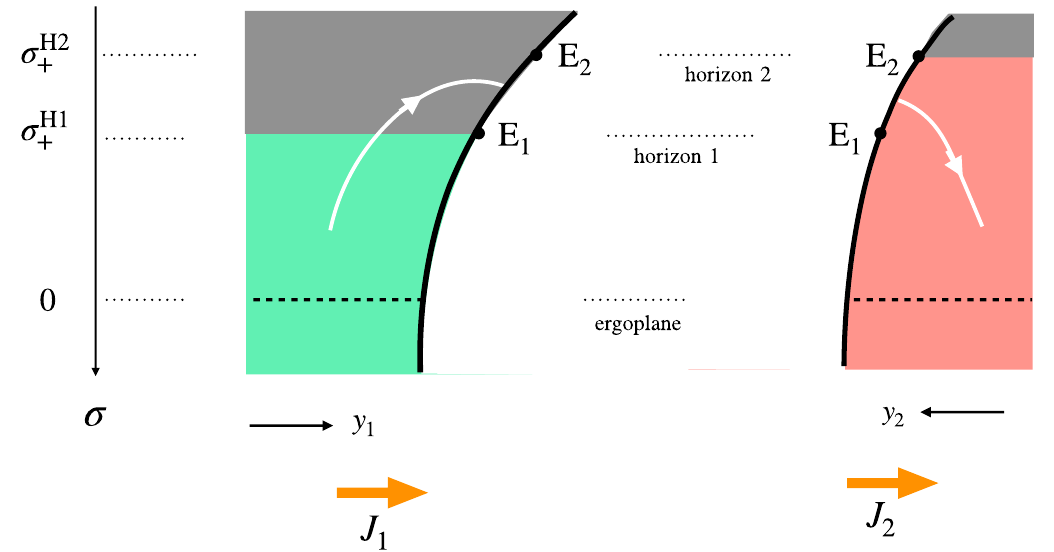
Figure 5 . A brane (thick black curve) entering the local outer horizons H 1 and H 2 (the boundaries of the grey regions in the figure) at two different points E1 and E2. The piece [E1,E2] of the wall is behind the horizon of slice 1 but outside the horizon of slice 2. The thick orange arrows show the direction of heat flow. The white curve is the worldline of an observer entering H 1 , crossing the brane and emerging outside H 2